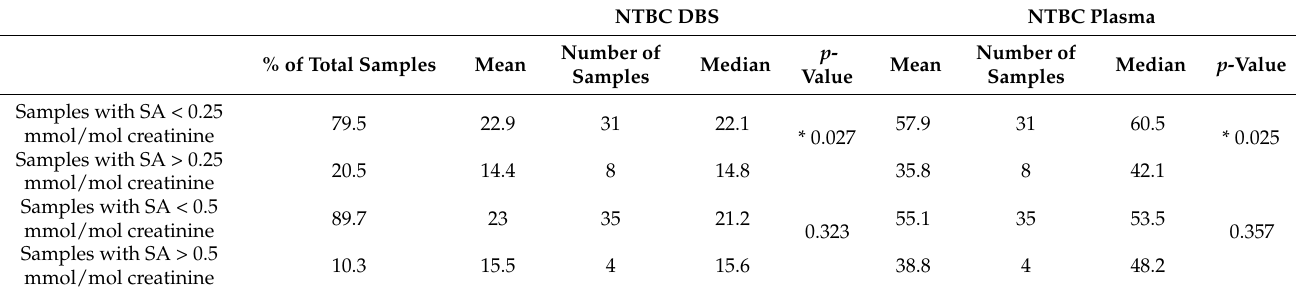
Table 2. NTBC concentration in plasma and DBS samples at two COVs for succinylacetone levels in urine.